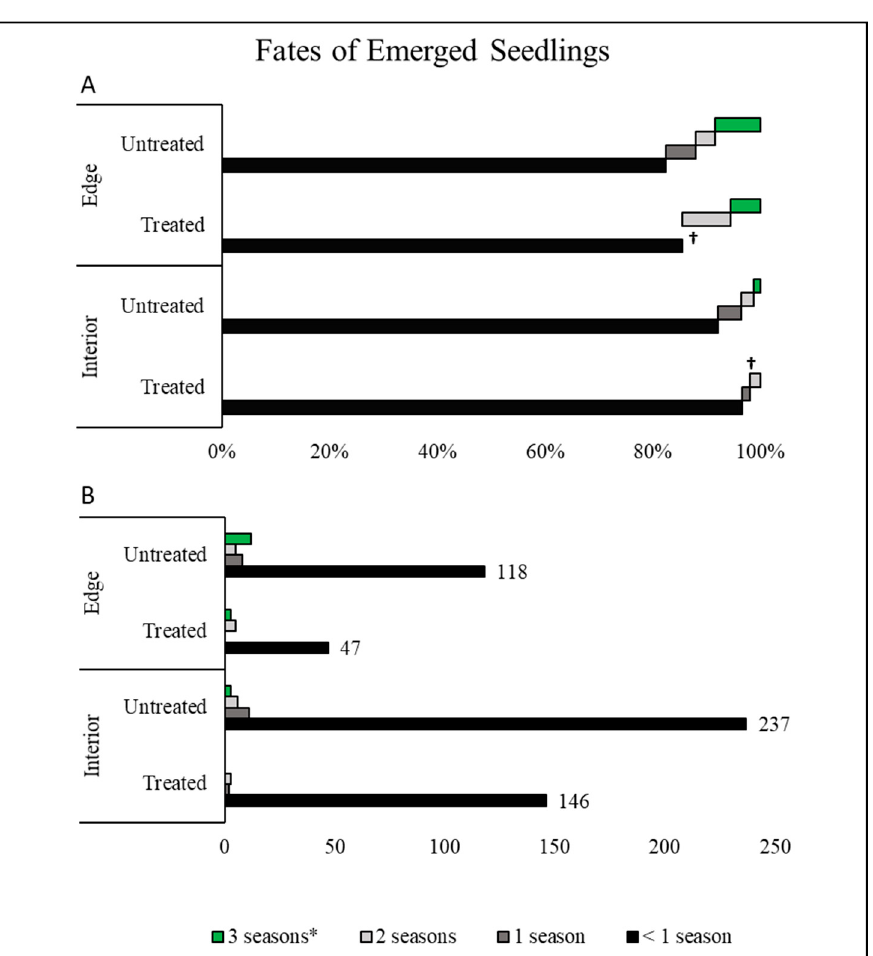
Figure 1. Distribution of poison ivy ( Toxicodendron radicans ) seedling fates for seeds that were “treated” or “untreated”, grown in either the forest edge or interior, represented as ( A ) percentage of total within treatment and ( B ) raw counts (floating values by the bars). Drupes that did not produce seedlings were excluded. A cross (†) indicates that there were no plants whose fate placed them within that category. An asterisk (*) signifies poison ivy plants that survived the duration of the